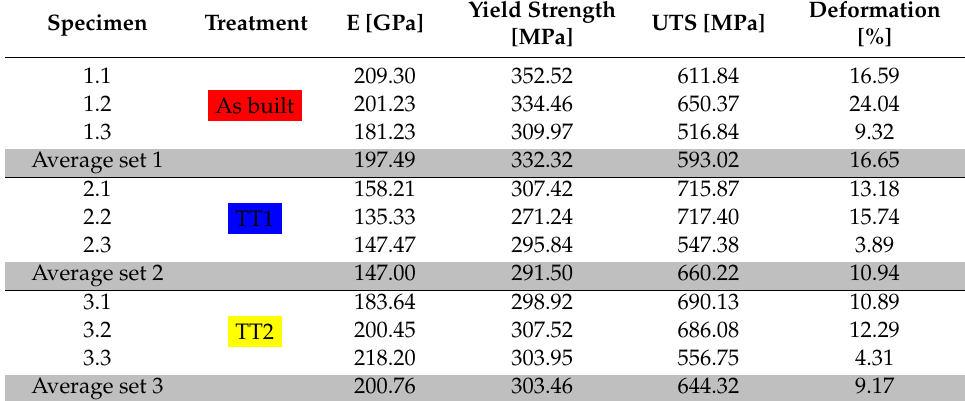
Table 5. Mechanical and physical properties of the specimens produced in air atmosphere condition.